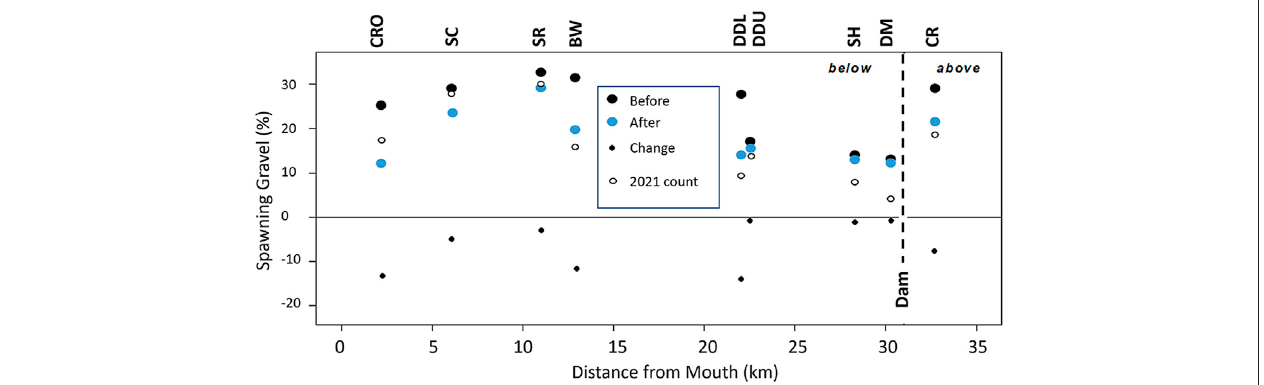
FIGURE6 | Changesin mean percent spawning gravel following dam removal at sites above and below theformer San Clemente Dam (vertical bar). Site locations shown in Figure 1 . Data in Table 1 .